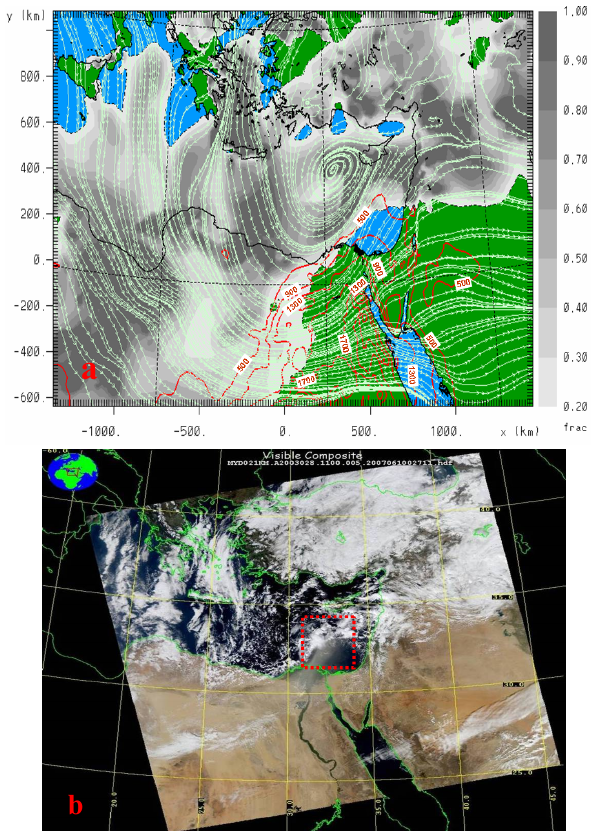
Fig. 6. (a) Cloud cover percentage (greyscale), streamlines at first model layer (green contours), dust – load (red contours in mgm − 2 ) and (b) MODIS-Aqua visible channel, on 28 Jan- uary 2003 11:00UTC. Dust transportation is obvious over the Southeastern part of Mediterranean. The red dashed rectangular indicates the location of convective clouds due to frontal